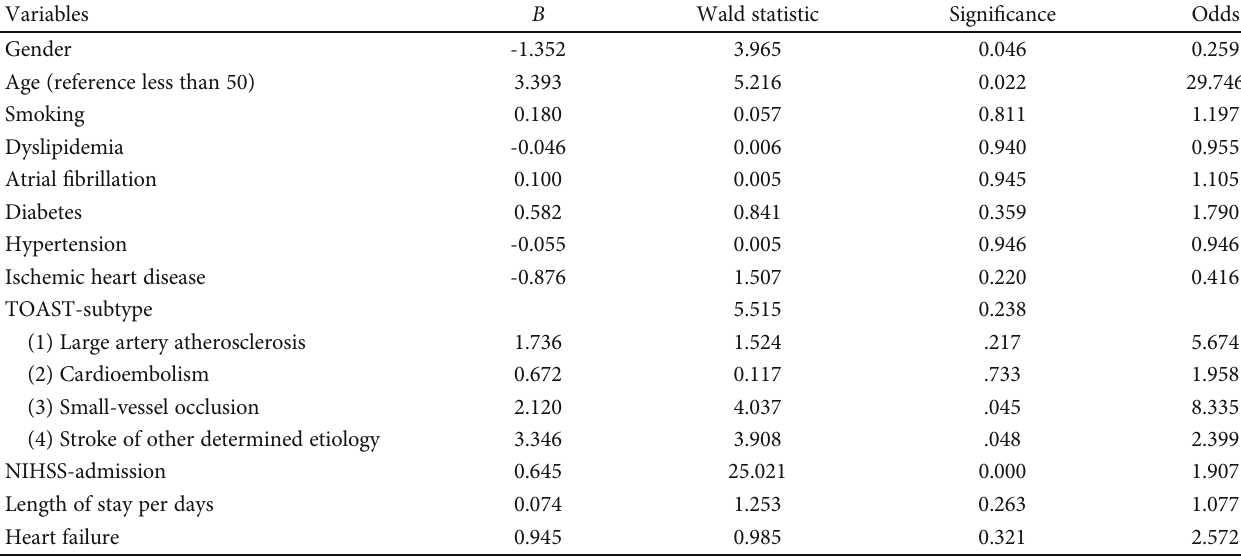
Table 8: Logistic regression on the impact of independent variables on mRS score.